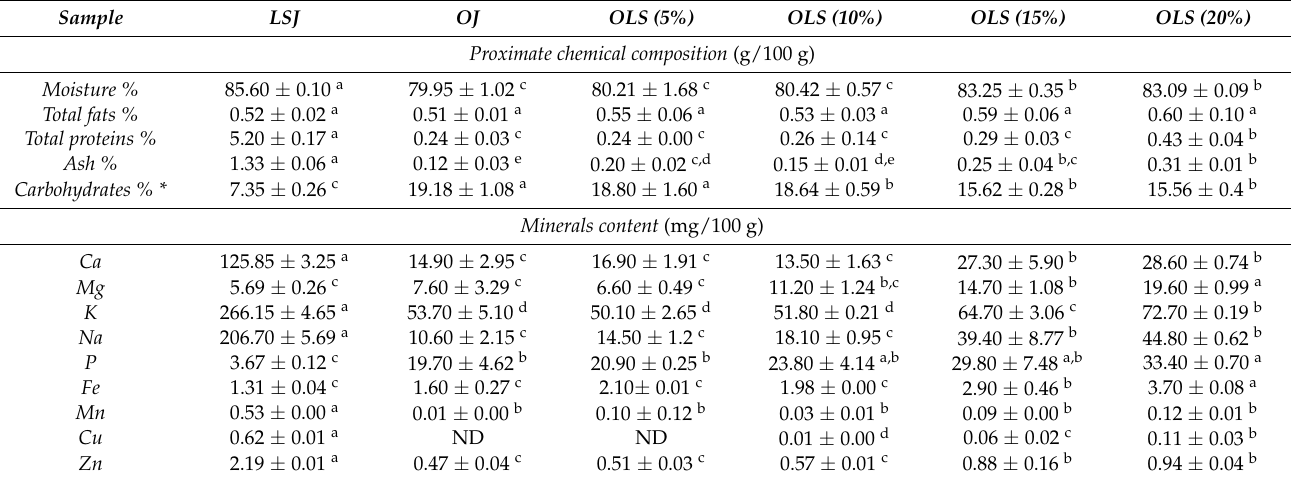
Table 4. Proximate chemical composition and minerals content of orange juice mixed with beetroot stem–leaf juice in different